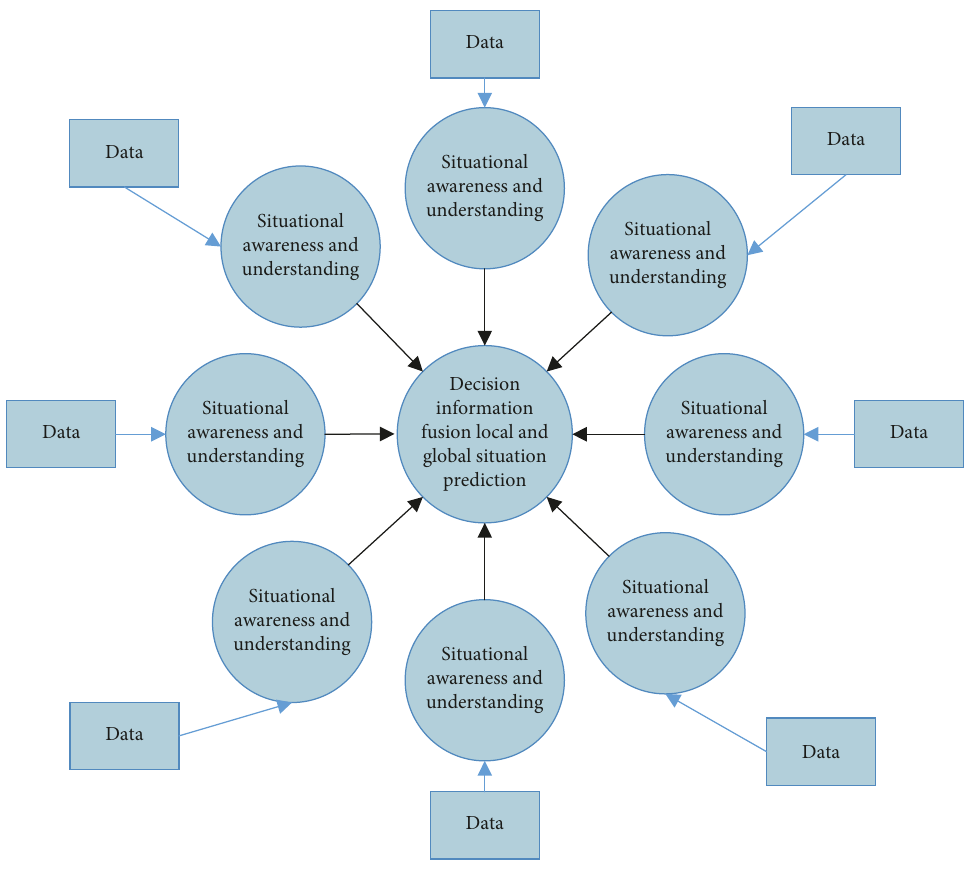
Figure 3: security situation awareness model based on a star